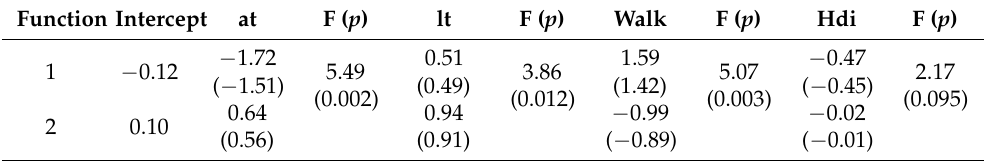
Table 3. Raw and standardized ( β in brackets) coefficients of 1st and 2nd discriminant function. Function Intercept